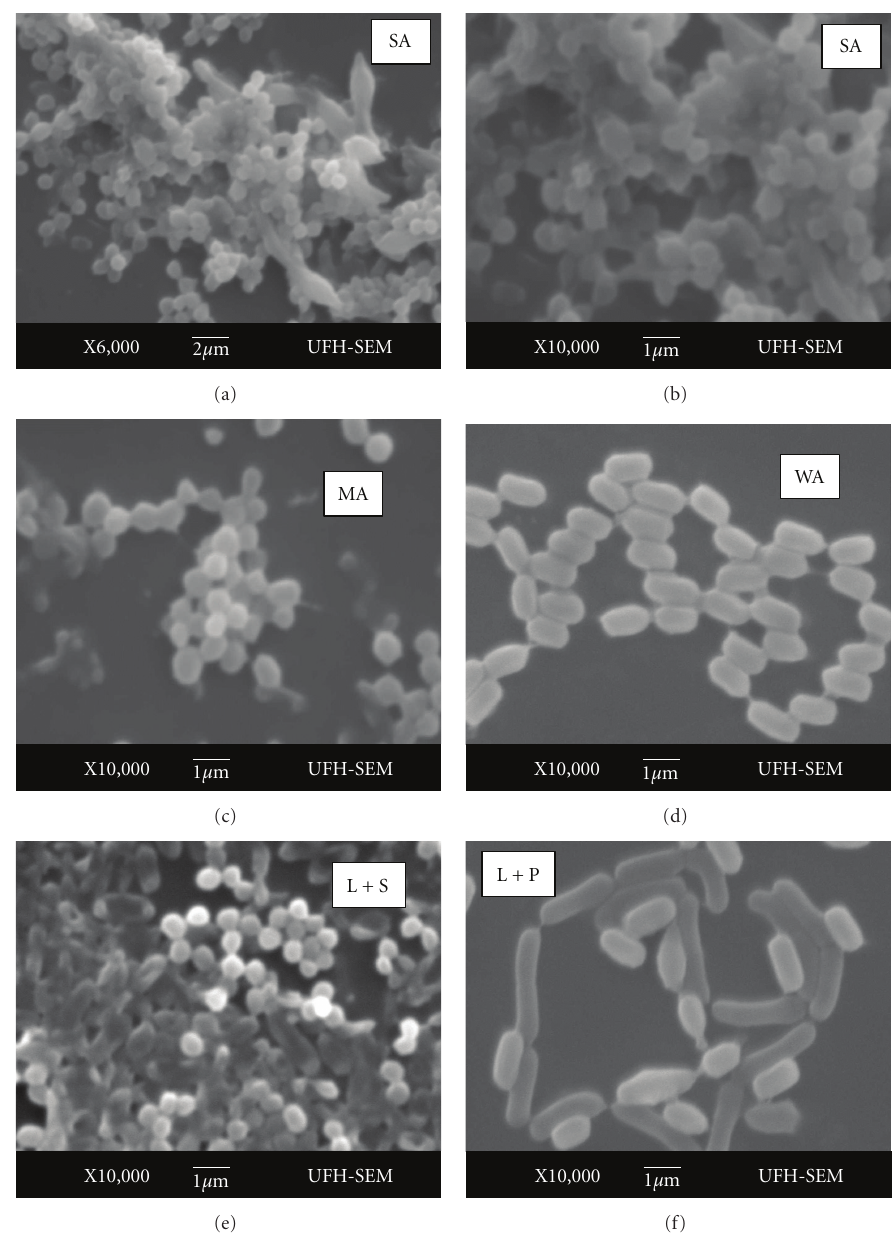
Figure 1: Scanning electron micrographs of autoaggregates and coaggregates biofilms of L. ivanovii and their coaggregates partner S. aureus NCTC 6571 and P. aeruginosa ATCC 15442. SA, strong adherent autoaggregate; MA, moderate adherent autoaggregate; WA, weak adherent autoaggregate; L + S, coaggregates of L. ivanovii and S. aureus ; L + P, coaggregates of weak adherent L. ivanovii and P. aeruginosa